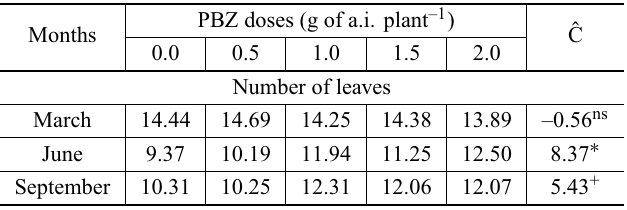
Means of the number of leaves of banana plants ‘Prata Anã’ and ‘FHIA 01’ in function of paclobutrazol doses (PBZ), along the experiment